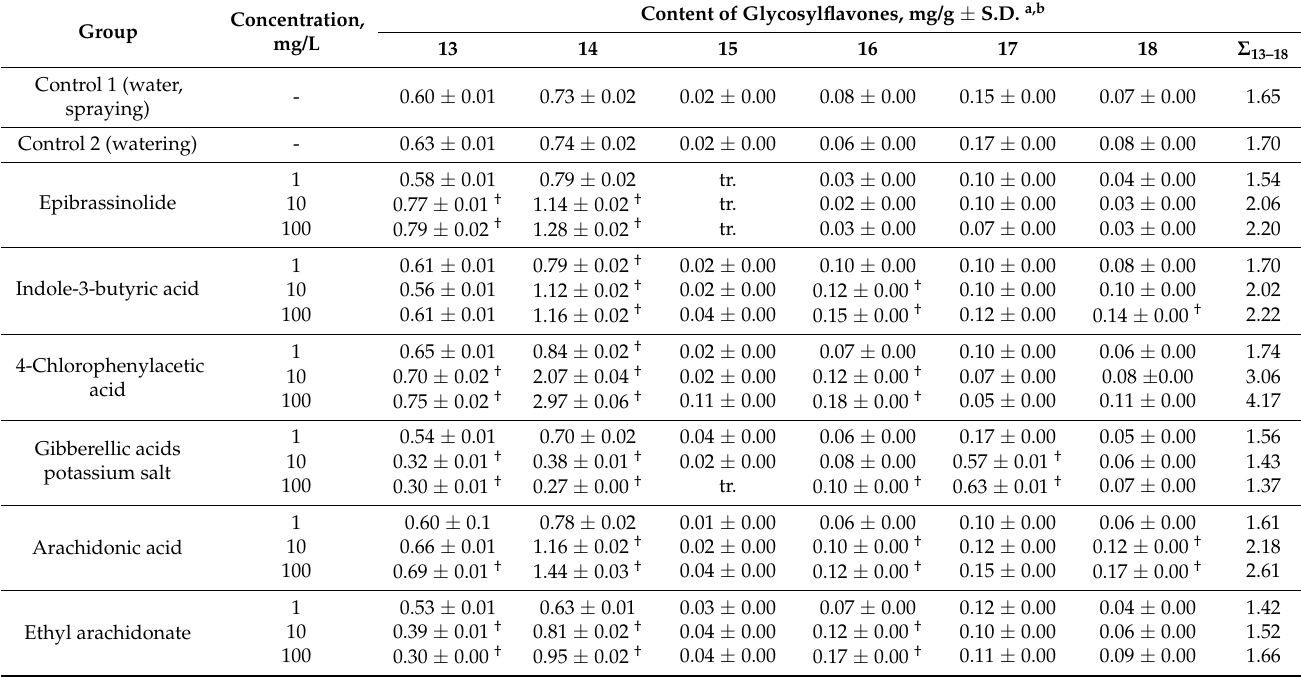
Table 2. Content of glycosylflavones in leaves of S. repens seedlings after 1 month of phytohormones and elicitors treatment. Concentration, Group mg/L